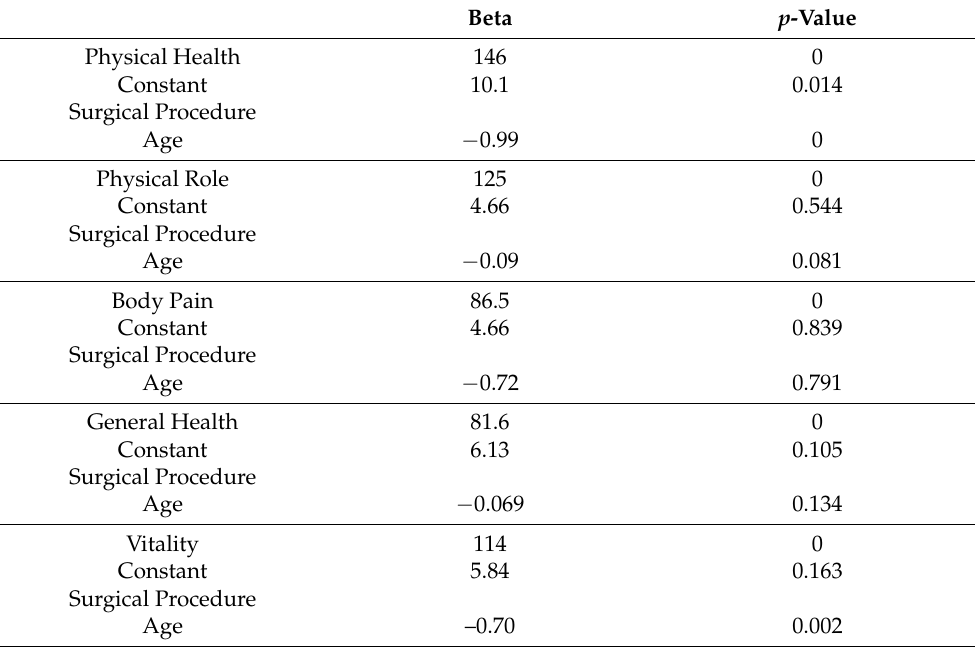
Table 3. Linear regression analysis of the relationship between age and surgical procedure with the score on the quality of life scales (SF-36) of patients operated on for abdominal aortic aneurysm. Beta p -Value Physical Health 146